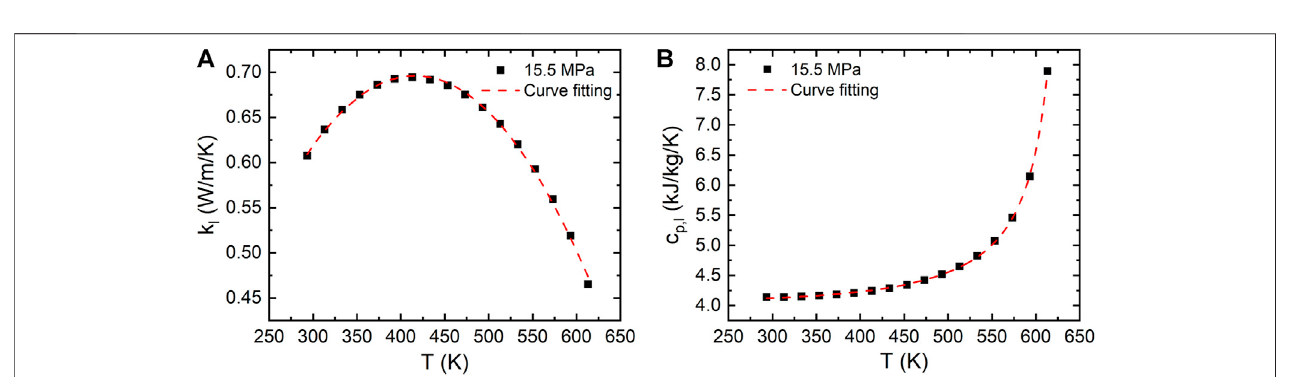
FIGURE 5 | Thermal conductivity (A) and speci fi c heat capacity (B) of liquid under 15.5 MPa.